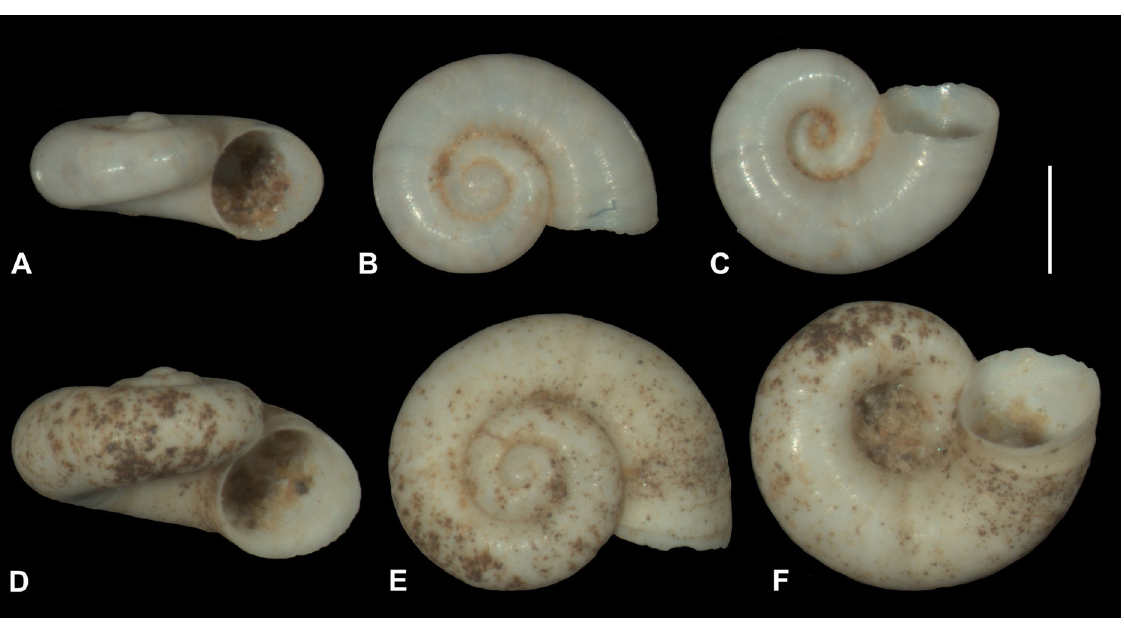
Fig. 12. Holotypes. A–C . H. lozekiana sp. nov. (NHMW 113638). D–E. H. steffeki sp. nov. (NHMW 113640). Scale bar = 500